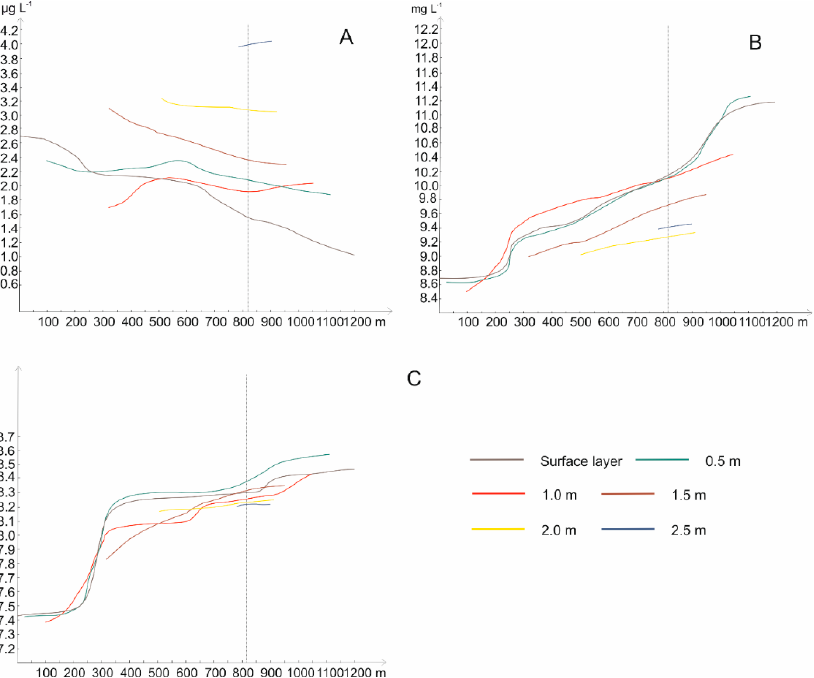
Figure 5. Variability of: ( A ) Chl-a; ( B ) DO; and ( C ) pH conditions along the main inlet–deepest point of the lake–outlet transect.